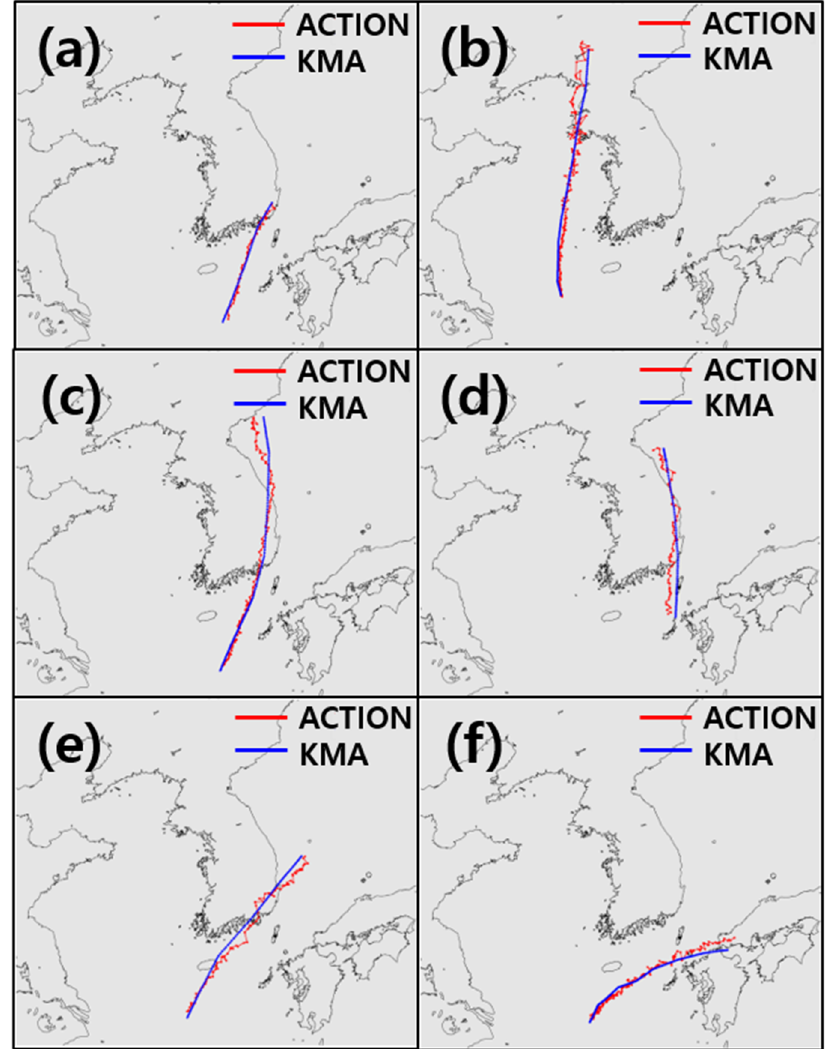
Figure 10. Comparison of ACTION results and KMA best track of typhoons that affected the Korean Peninsula between 2020–2021: ( a ) “JANGMI”, ( b ) “BAVI”, ( c ) “MAYSAK”, ( d ) “HAISHEN”, ( e ) “OMAIS”, and ( f ) “CHANTHU”.